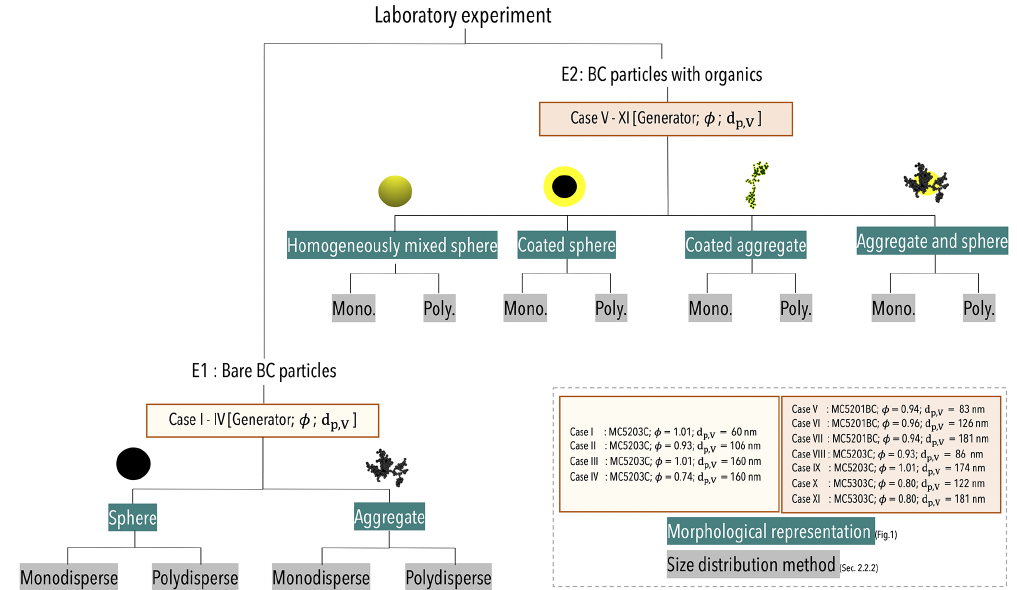
Figure 2. Schematic overview of the various experimental cases, morphological representations, and size distribution methods used to model the optical properties.